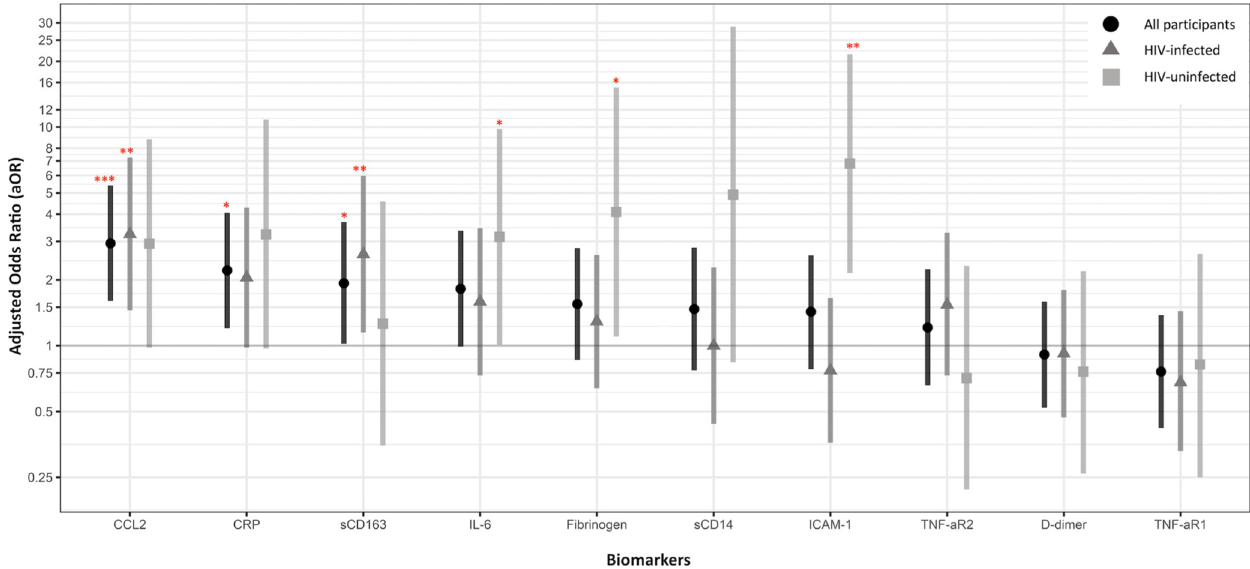
Fig 1. Association of inflammatory biomarkers (fifth quintile, relative to first quintile) with the presence of focal carotid plaque. Models are adjusted for age, race/ethnicity, baseline education, study center, enrollment in the MACS cohort (pre- and post-2001), SBP, BMI, total cholesterol, HDL cholesterol, alcohol consumption since last visit, smoking status with cumulative pack year use, HCV, and use of medication for hypertension, diabetes and high cholesterol. Data points are adjusted odds ratios (aOR), and bars denote 95% confidence intervals (CI). Dark gray horizontal line represents the null value (aOR = 1.00). Level of significance, � p < 0.05, �� p < 0.01, ��� p < 0.001. Values of the aOR (95% CI), from left to right: All participants (N = 728): CCL2 [2.94 (1.60, 5.40)], CRP [2.21(1.20, 4.06)], sCD163 [1.93 (1.02, 3.68)], IL-6 [1.82 (0.99, 3.36)], Fibrinogen [1.55 (0.86, 2.80)], sCD14 [1.47 (0.77, 2.81)], ICAM-1 [1.43 (0.78, 2.59)], sTNF- α R2 [1.21 (0.66, 2.24)], D-dimer [0.91 (0.52, 1.59)] and sTNF- α R1 [0.76 (0.42, 1.38)]. HIV-infected (N = 452): CCL2 [3.24 (1.45, 7.24)], CRP [2.05 (0.98, 4.28)], sCD163 [2.62 (1.15, 5.97)], IL-6 [1.59 (0.73, 3.45)], Fibrinogen [1.29 (0.64, 2.60)], sCD14 [1.00 (0.44, 2.28)], ICAM-1 [0.77 (0.36, 1.65)], sTNF- α R2 [1.54 (0.72, 3.29)], D-dimer [0.92 (0.47, 1.80)] and sTNF- α R1 [0.68 (0.33, 1.44)]. HIV-uninfected (N = 276): CCL2 [2.93 (0.98, 8.78)], CRP [3.23 (0.97, 10.82)], sCD163 [1.25 (0.35, 4.570], IL-6 [3.15 (1.01, 9.81)], Fibrinogen [4.09 (1.10, 15.18)], sCD14 [4.91 (0.84, 28.82)], ICAM-1 [6.8 (2.15, 21.54)], sTNF- α R2 [0.71(0.22, 2.32)], D-dimer [0.76 (0.26, 2.19)] and sTNF- α R1 [0.82 (0.25,